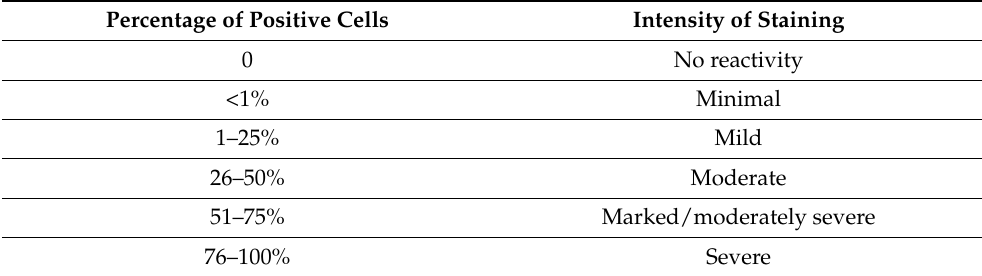
Table 3. The Grading of